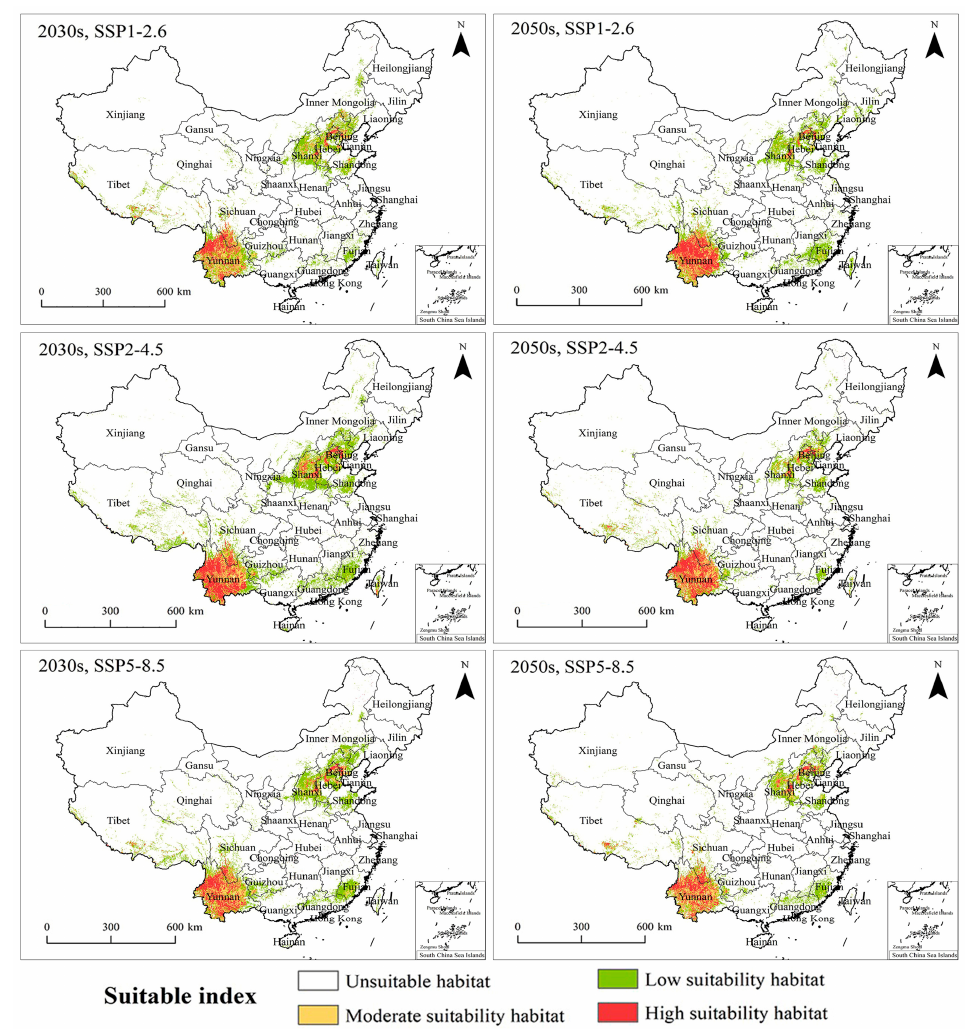
Figure 5. PGDs (Potential Geographical Distributions) of Tagetes minuta under different climate change pathways (SSP1-2.6; SSP2-4.5; SSP5-8.5) during the 2030s and 2050s in China. During the 2030s, under SSP1-2.6, the highly suitable habitat area of T. minuta was predicted to be 13.12 × 10 4 km 2 , the moderate-suitability habitat area was predicted to be 21.79 × 10 4 km 2 , and the total habitat area was predicted to be 80.61 × 10 4 km 2 , accounting for 1.37%, 2.27%, and 4.76% of China, respectively. During the 2050s, under SSP1-2.6, the high-suitability habitat area of T. minuta was predicted to be 17.99 × 10 4 km 2 , the moderate-suitability habitat area was predicted to be 15.61 × 10 4 km 2 , and the total habitat area was predicted to be 83.11 × 10 4 km 2 , accounting for 1.87%, 1.63%, and 5.16% of China, respectively (Figure 6). From the 2030s to the 2050s, under SSP1-2.6, low-suitability habitats in North China and Southwest China and highly suitable habitats in the northwest of Yunnan Province showed a growing trend. From the present to the 2030s, the area where unsuitable habitats shifted to low-suitability habitats was predicted to be 22.58 × 10 4 km 2 , and the area where moderate-suitability habitats shifted to high-suitability habitats was predicted to be 5.38 × 10 4 km 2 . From the 2030s to the 2050s, the area in which unsuitable habitats shifted to low-suitability habitats was predicted to be 20.83 × 10 4 km 2 , and the area where moderate-suitability habitats shifted to high-suitability habitats was predicted to be 7.09 × 10 4 km 2 (Figure 7). During the 2030s, under SSP2-4.5, the high-suitability habitat area of T. minuta was predicted to be 2.27 × 10 4 km 2 , the moderate-suitability habitat area was predicted to be 20.15 × 10 4 km 2 , and the total habitat area was predicted to be 87.09 × 10 4 km 2 , accounting for 2.27%, 2.1%, and 6.74% of China, respectively. During the 2050s, under SSP2-4.5, the